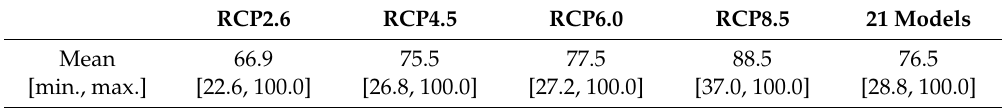
Table 3. Future projections of beach loss rate in Japan by Udo and Takeda (2017).